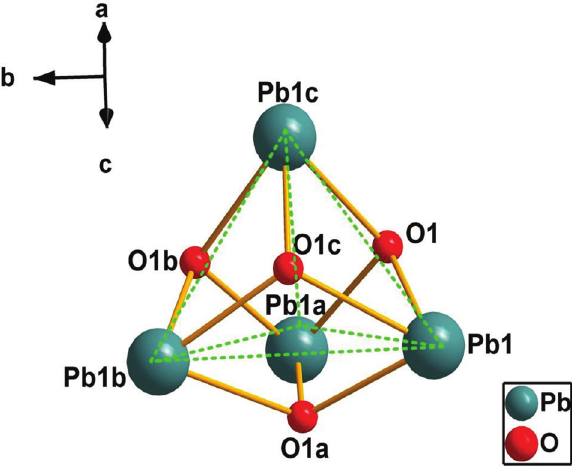
O core (adjacent Pb atoms linked by green 4 4